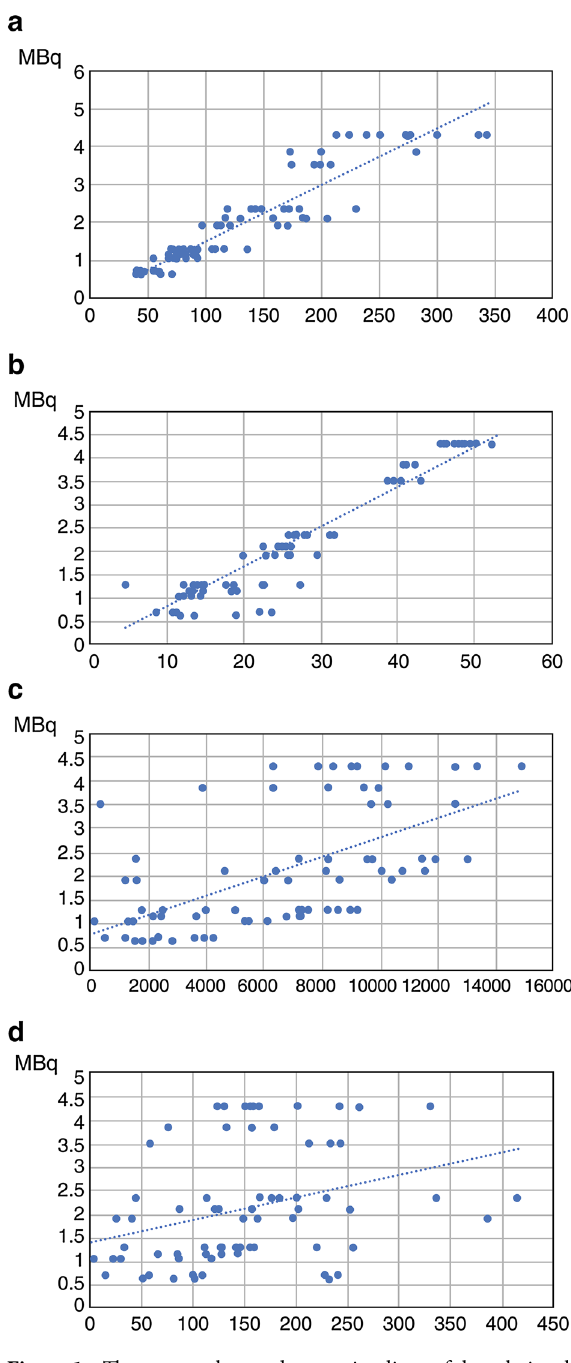
Figure 1. The scatter plots and regression lines of the relationship between the intensity and the actual radiation dose. The intensity is shown in maximum intensity in the planar image ( a ), averaged intensity in the planar image ( b ), maximum intensity in the single-photon emission computed tomography (SPECT) image ( c ), and averaged intensity in the SPECT image ( d